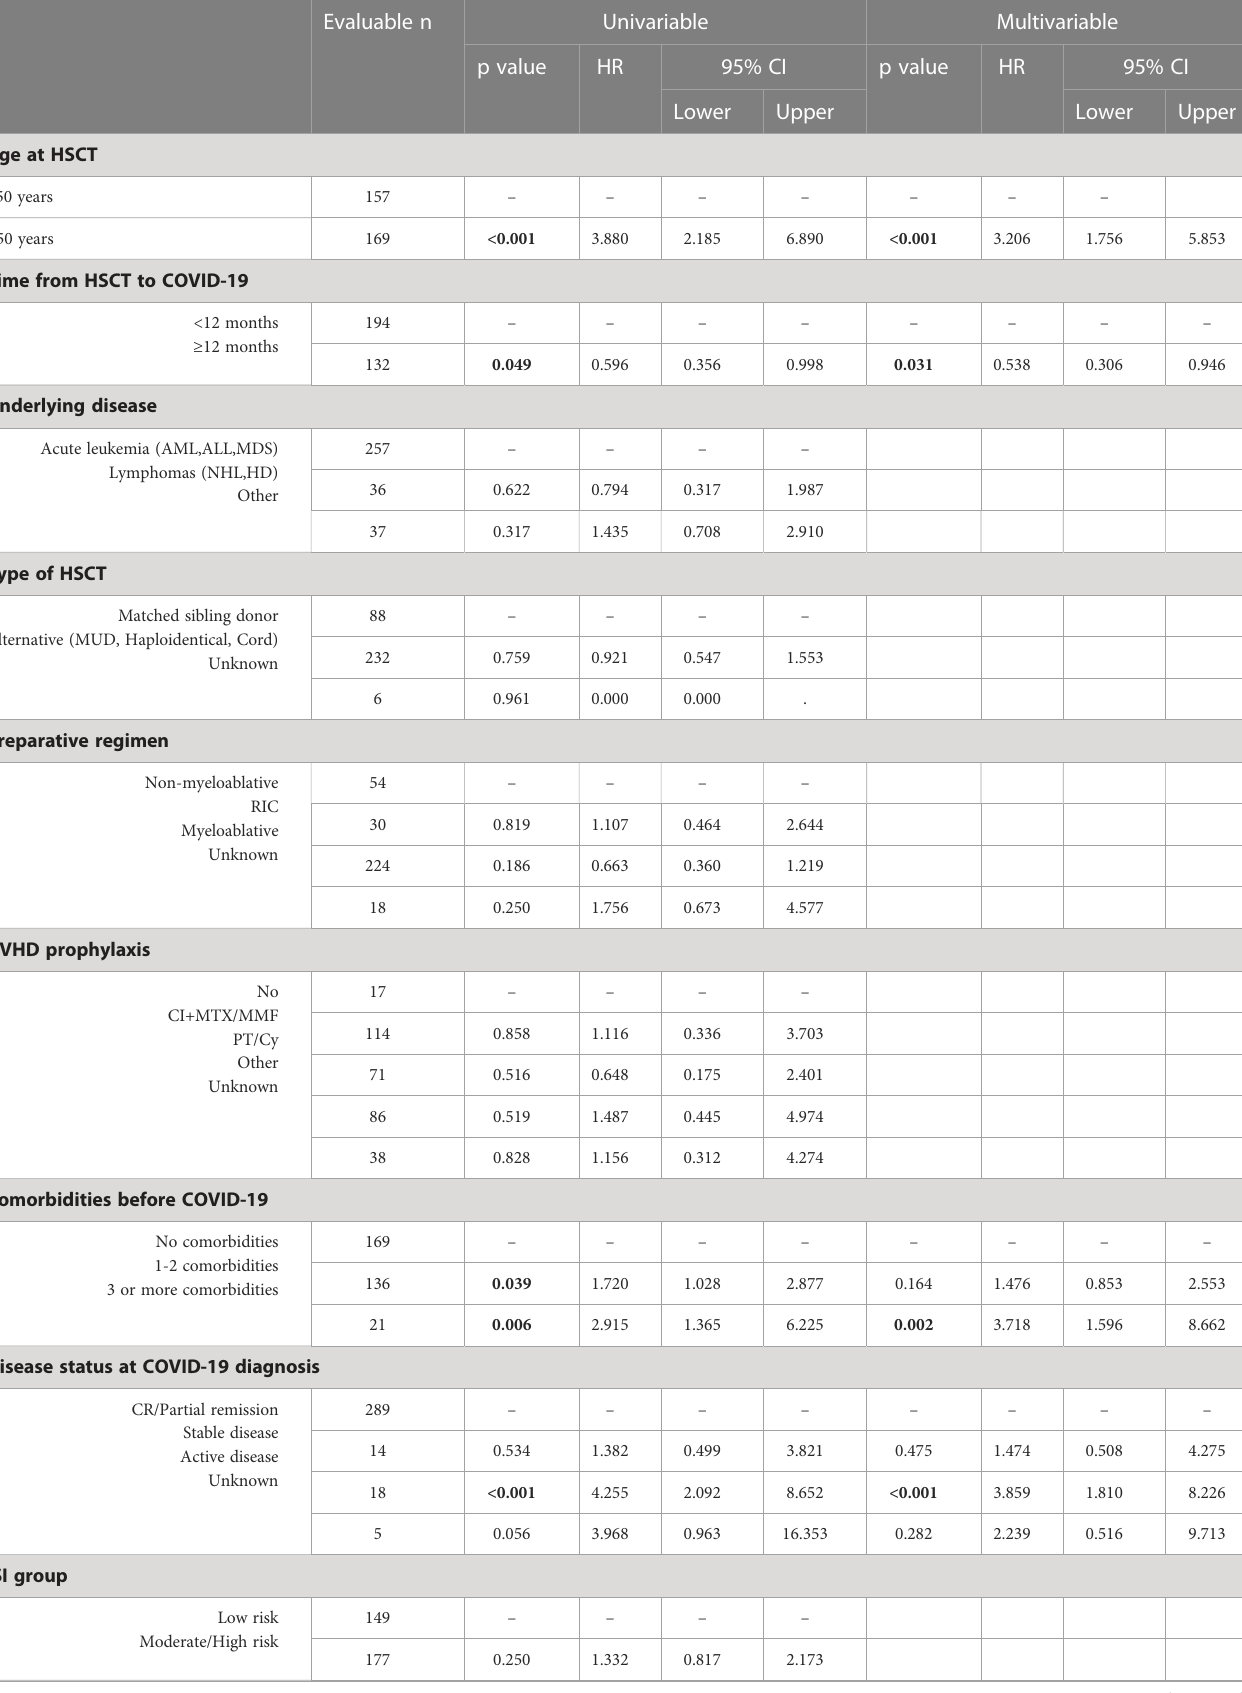
TABLE 3 Univariate and multivariate analysis for risk factors associated with COVID-19